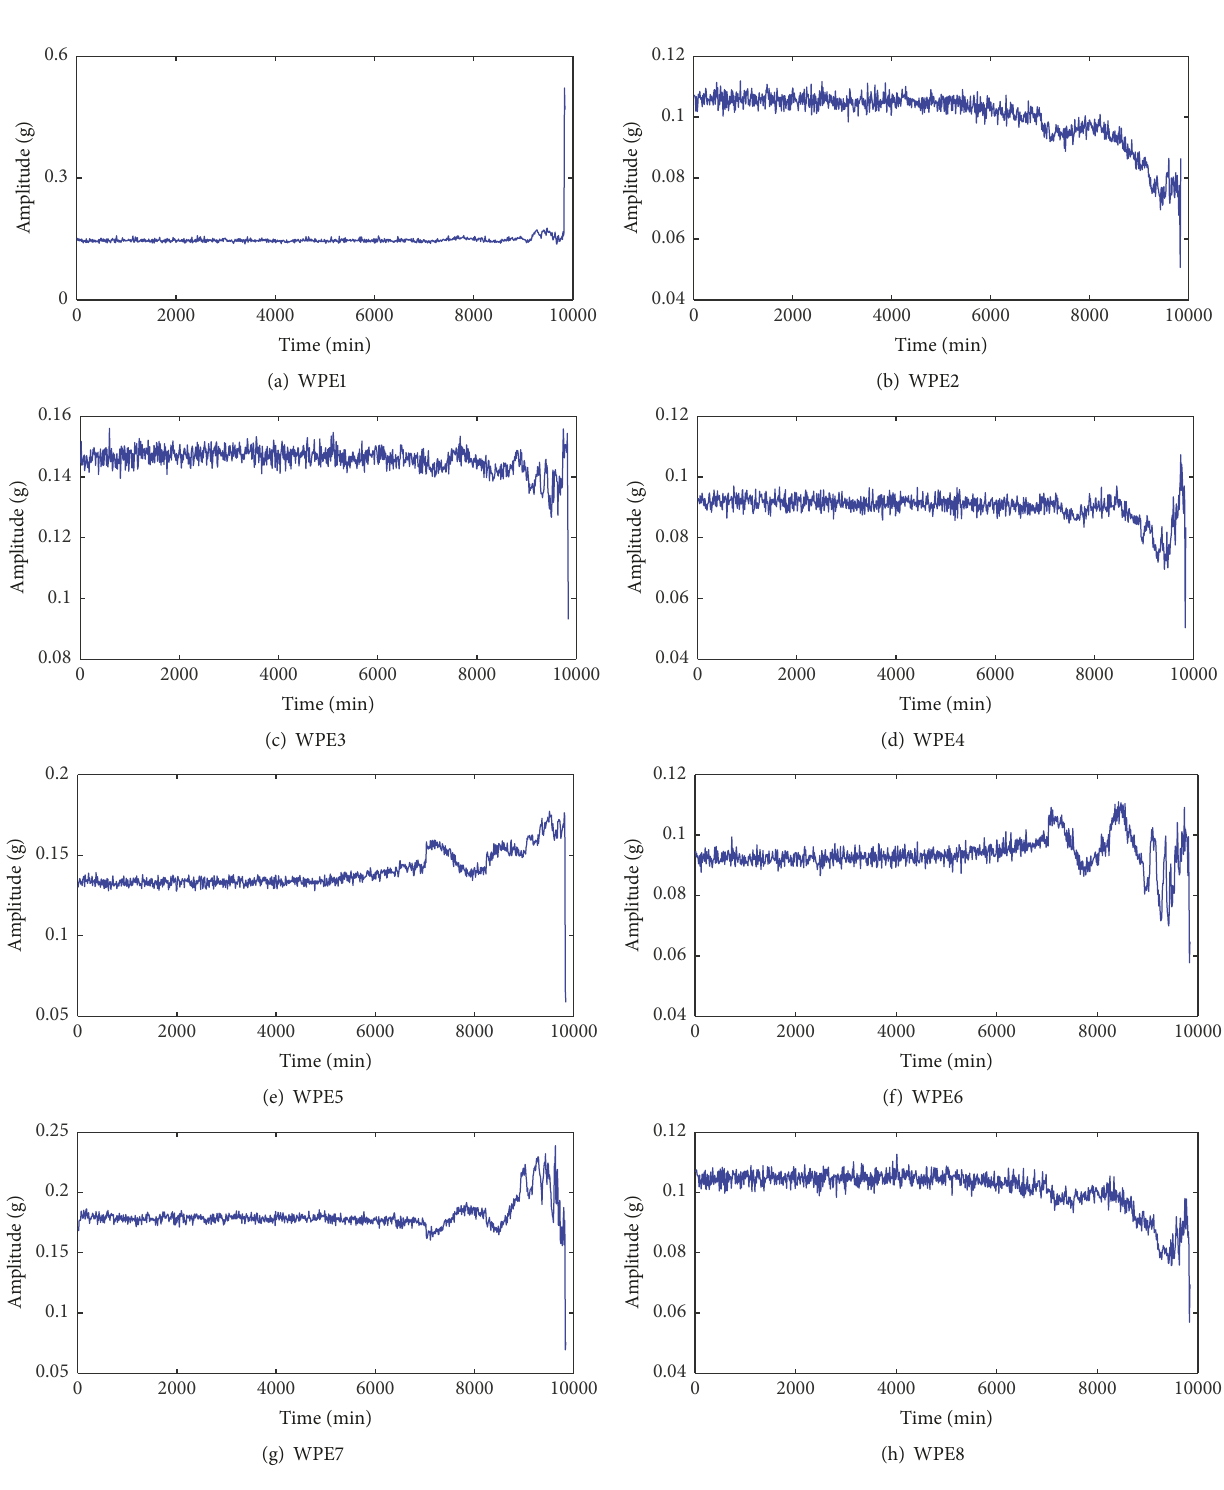
Figure 7: Eight wavelet packet energy